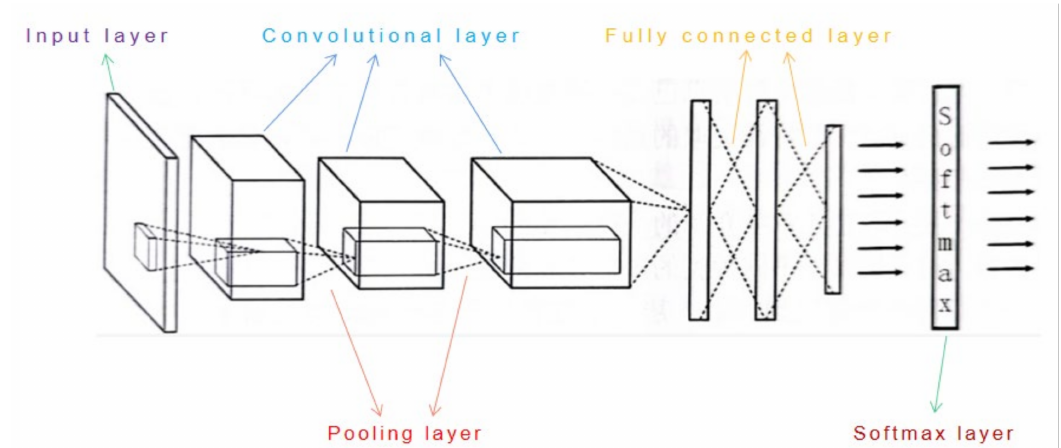
Figure 2. Convolutional neural